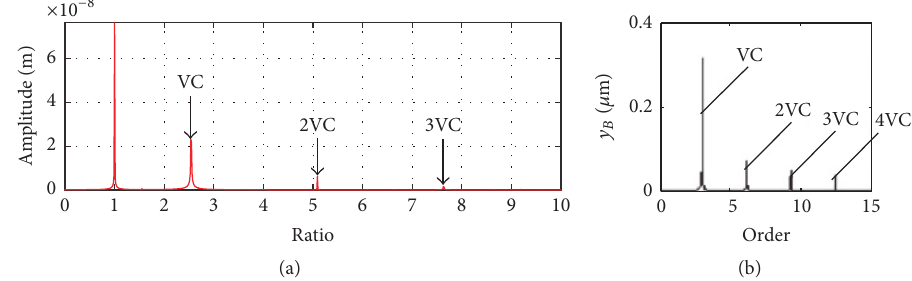
Figure 5: Rotor response of frequency spectrum (a) in this paper (b) in [11].